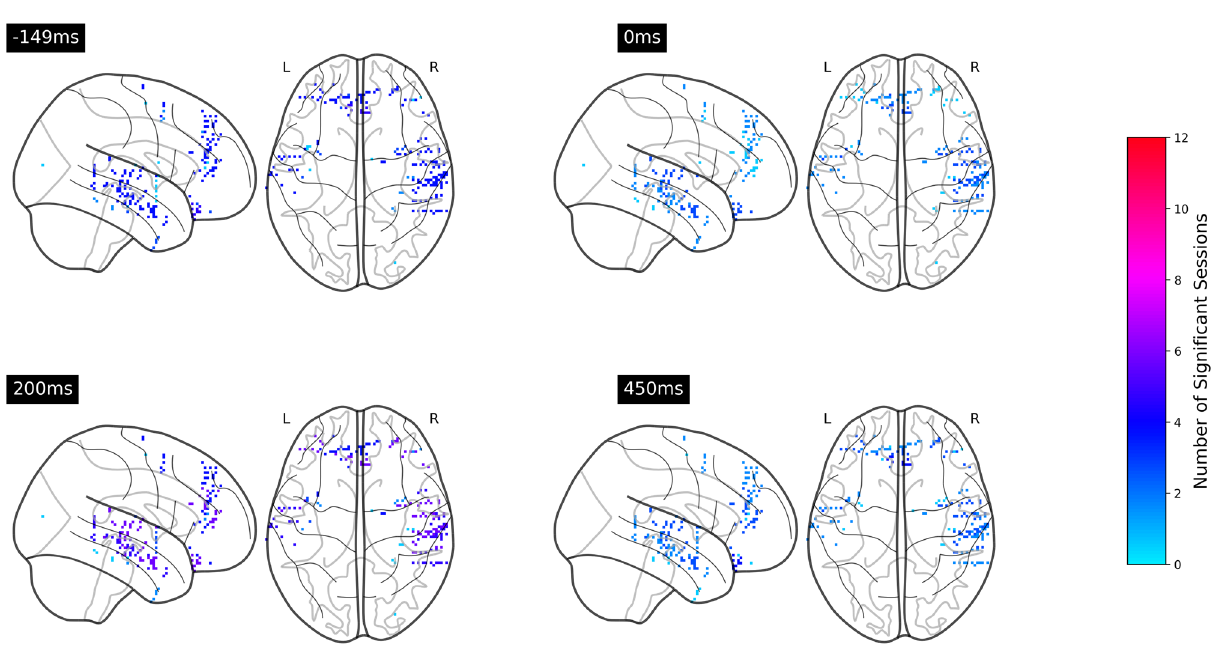
Figure 6. Number of significant sessions within each cortex at − 149 , 0, 200, 450 ms relative to the note onsets. The electrodes were mapped onto a common MNI space. In the integration analysis, although the location of electrodes differed across sessions, all the electrodes within a cortex have identical color for the purpose of visualization